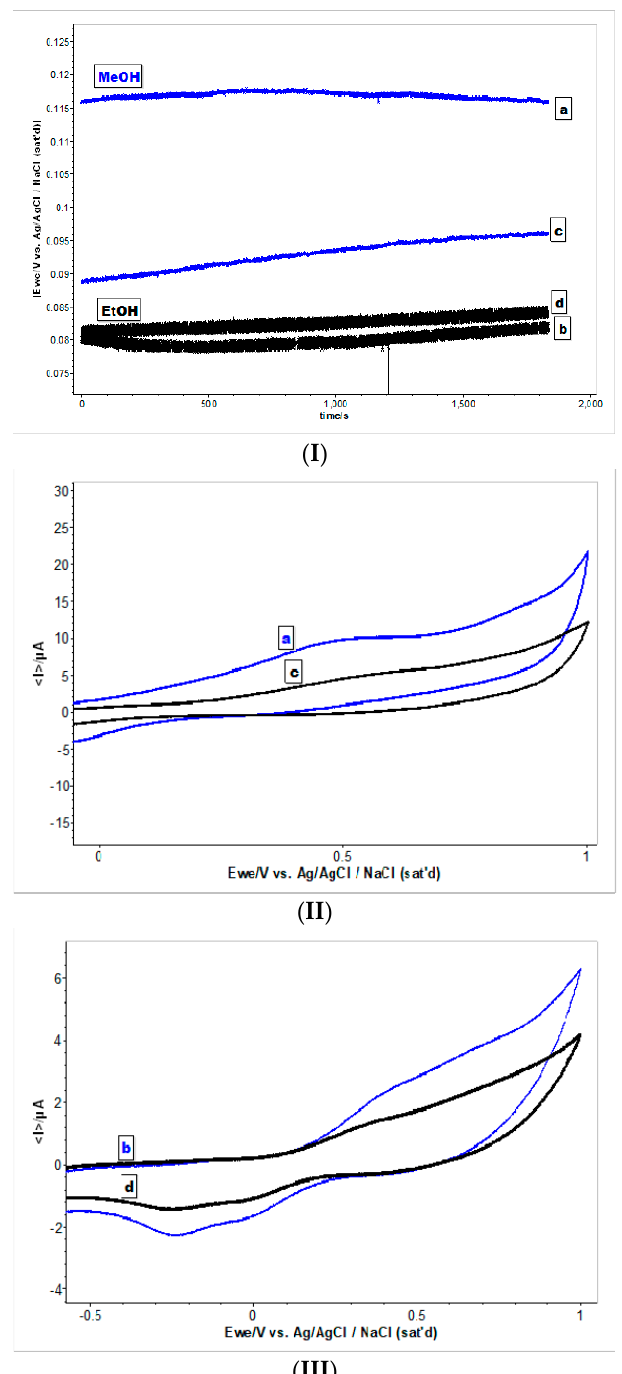
Figure 5. (I) OCV registered for basil methanolic extracts of AB ( a ) and MB ( c ) and, respectively for ethanolic extracts of AB ( b ) and MB ( d ). ( II ) Cyclic voltammograms recorded for basil methanolic extracts of AB (a-blue) and MB (c-black), E = ±1 V/Ag/Ag Cl sat , at 100 mVs − 1 . (III) Cyclic voltammograms recorded for basil ethanolic extracts of AB (c-blue) and MB (d-black), E = ±1 V/Ag/Ag Clsat, at 100 mVs − 1 .